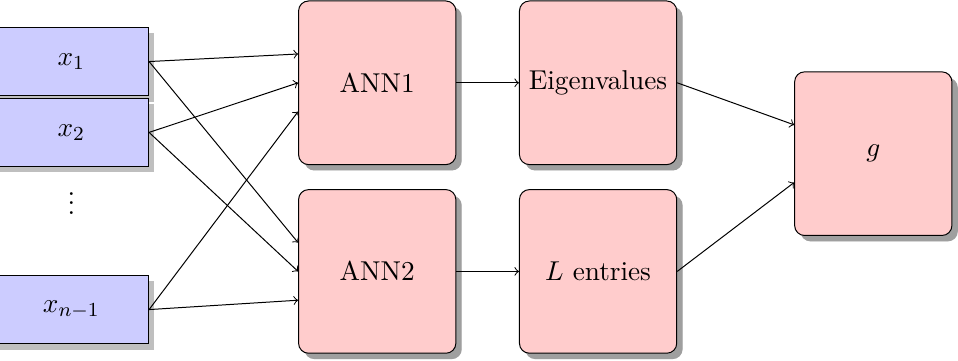
Figure 2 . Flow chart of the algorithm. Two separate neural networks provide the eigenvalues as well as the entries of the diagonal matrix L . They get combined into the metric g that is used to minimize the combined loss function for both networks